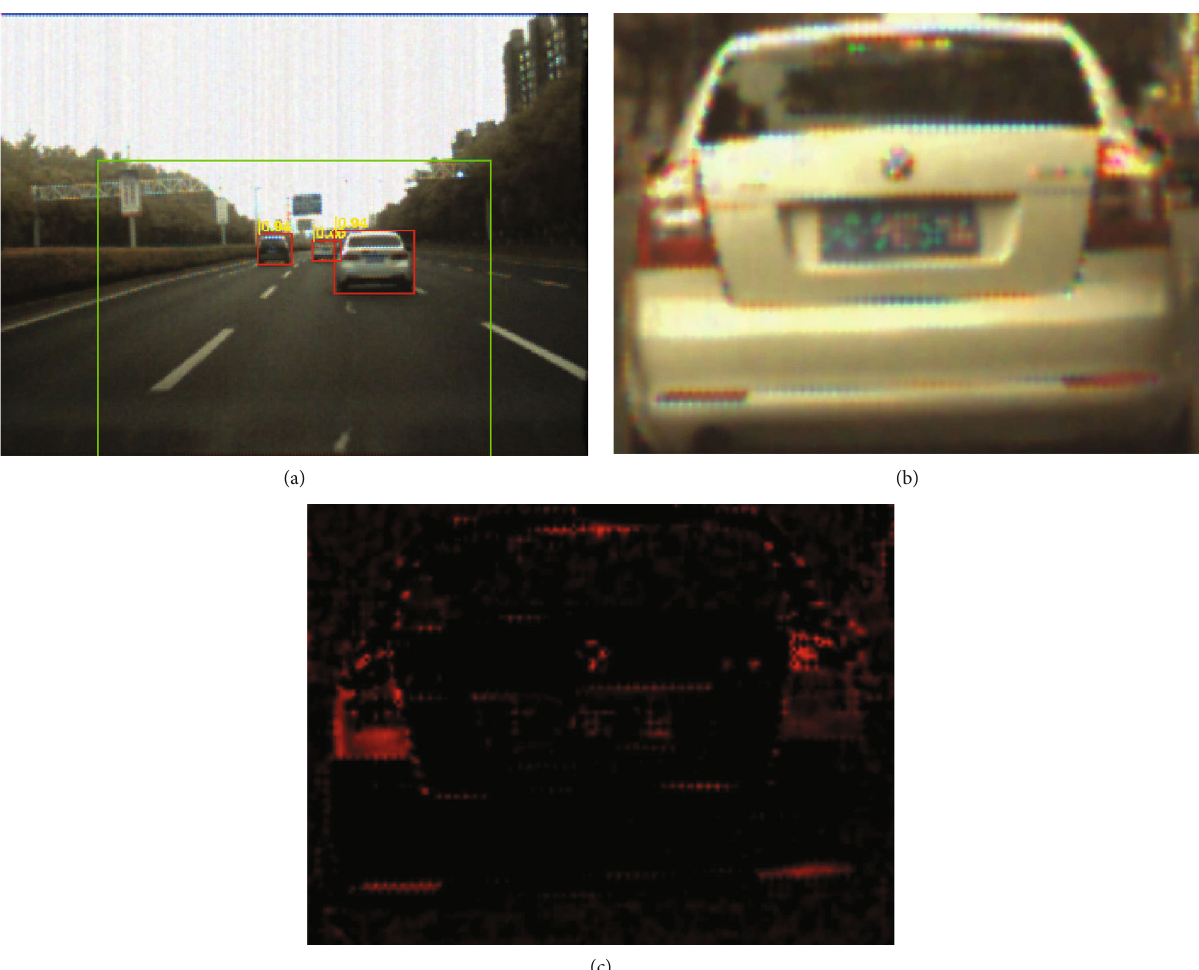
Figure 5: Illustration for vehicle detection. (a) Vehicle detection result. (b) Vehicle detected in an APS frame. (c) LR of the detected vehicle in